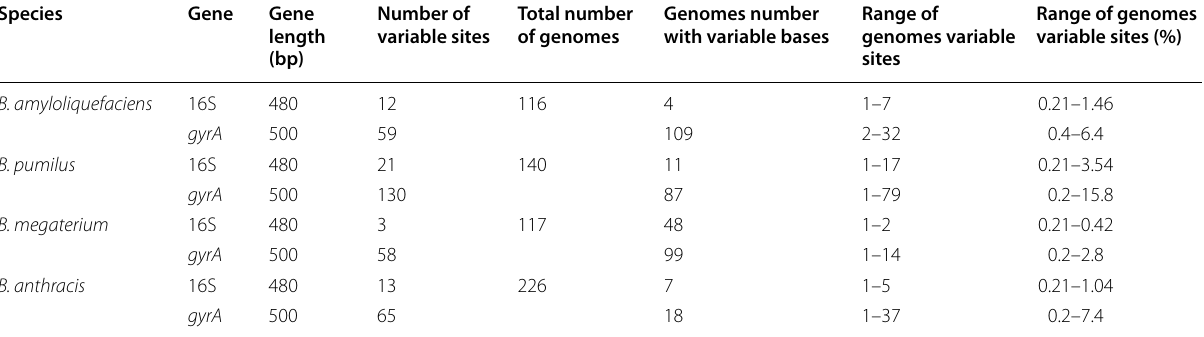
Table 1 Polymorphisms of the 16S rRNA and gyrA gene